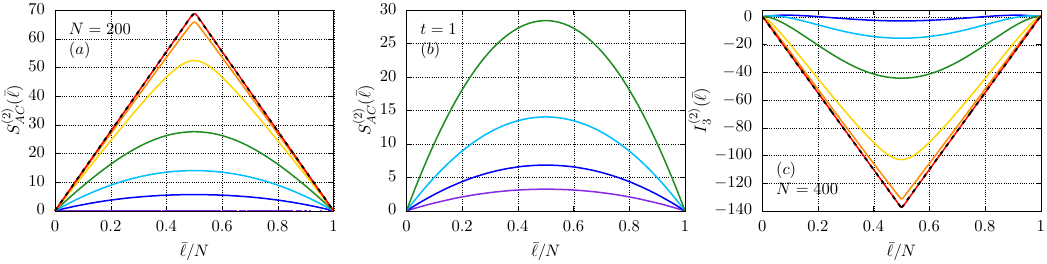
Figure 9 . Sub(cid:12)gure ( a ): R(cid:19)enyi-2 entropies S (2) for the subsystem A C , as displayed in (cid:12)gure 2, for AC [ N = 200 and di(cid:11)erent subsystem sizes (cid:22) ‘ . Solid lines correspond to the times t = 0 ; 0 : 4 ; 1 ; 2 ; 4 ; 6 ; 15 (from bottom to top). The black dashed line is obtained by Haar average as computed in ref. [9]. Sub(cid:12)gure ( b ): R(cid:19)enyi-2 entropies S (2) computed at t = 1, for di(cid:11)erent subsystem sizes (cid:22) ‘ . Solid AC lines correspond to system sizes N = 50 ; 100 ; 200 ; 400 (from bottom to top). Sub(cid:12)gure ( c ): R(cid:19)enyi-2 tripartite information (2.14) for N = 400 and di(cid:11)erent subsystem sizes (cid:22) ‘ . Solid lines correspond to the times t = 0 ; 0 : 4 ; 1 ; 2 ; 4 ; 6 ; 15 (from top to bottom). The black dashed line is obtained by Haar average as computed in ref.